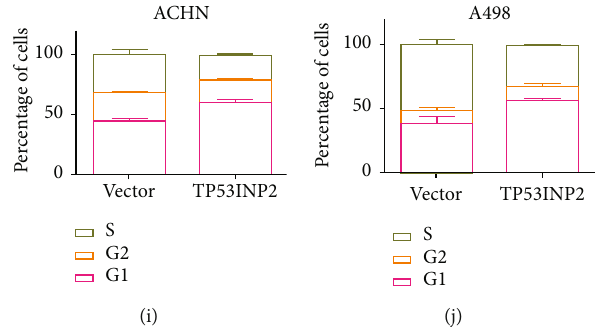
Figure 6: Overexpression of TP53INP2 resulted in an inhibition to cellular proliferation in ccRCC cell lines. (a) TP53INP2 overexpression was stably transfected into the 786-O, ACHN, and A498 ccRCC cell lines. The relative mRNA level of TP53INP2 was determined with qRT- PCR. (b) and (c) The level of TP53INP2 protein was determined with western blot. Relative values were estimated with Image J. (d) – (f) CCK-8 assay was made for the detection on the cell viability of 786-O, ACHN, and A498. (g) – (j) The fl ow cytometry was performed for the detection on the cell viability of 786-O, ACHN, and A498. Data were presented as mean ± SD of three or four independent experiments. ∗∗ P < 0 : 01 ; ∗∗∗ P < 0 : 001